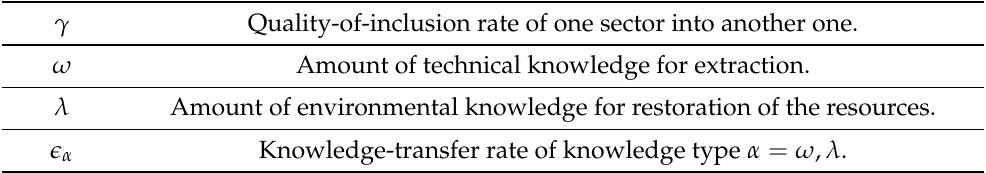
Table 2. Definitions of the parameters in Equations (3)–(6). The table is the authors’ own